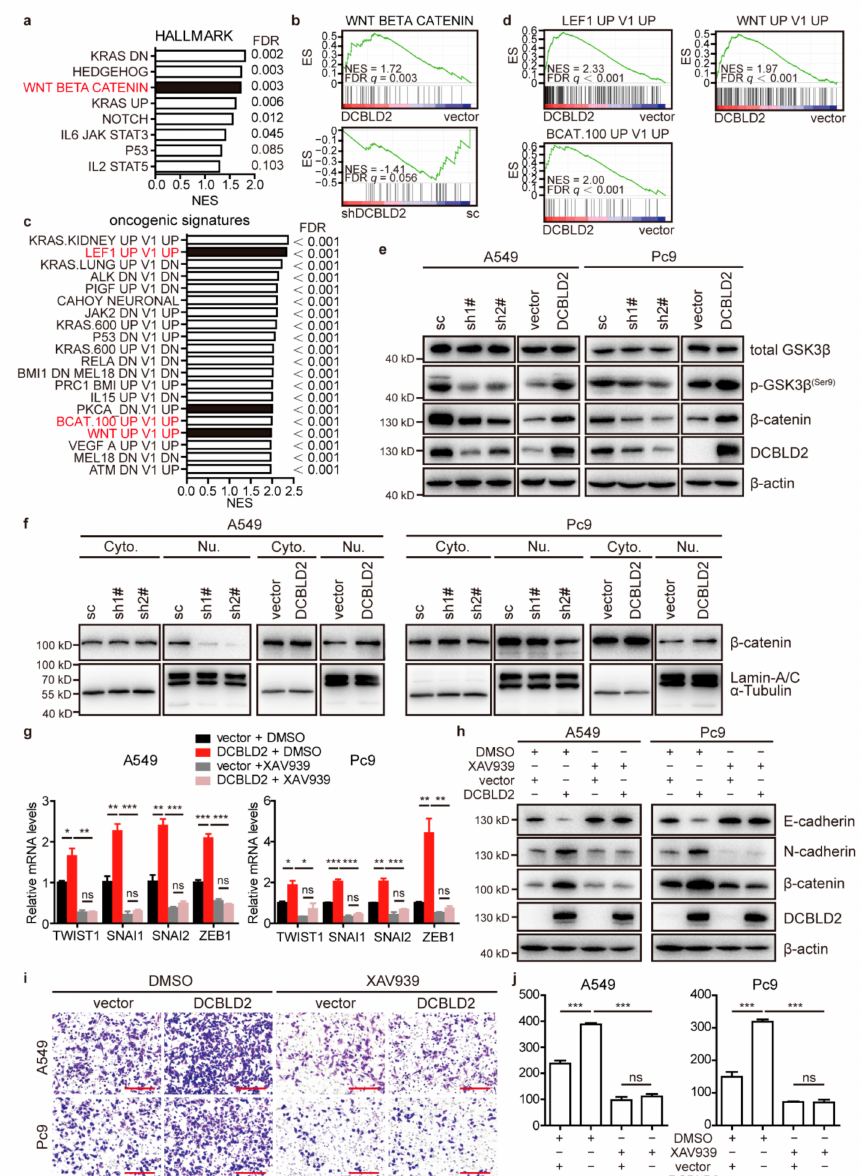
Figure 5. The Wnt/ β -catenin signaling pathway mediates DCBLD2-induced metastasis in LUAD. ( a , b ) Hallmark enrichment classification of signaling pathways of differentially expressed genes in empty vector and DCBLD2-overxpressing A549 cells by GSEA. ( c , d ) Oncogenic signature enrichment classification of differential genes by GSEA. ( e ) The expression of various Wnt/ β -catenin signaling pathway proteins was evaluated by western blot assay in A549 and Pc9 cells. ( f ) Western blot assay of β -catenin expression in A549 and Pc9 cells after nuclear-cytoplasmic fractionation. α -Tubulin and Lamin A/C were used as cytoplasmic and nuclear loading controls, respectively. ( g ) RT-PCR assays of the expression of EMT TFs in empty vector and DCBLD2-transfected cells after treatment with 20 µ M XAV939 or DMSO for 48 h. ( h ) Western blot assay of the expression of E-cadherin and N-cadherin in empty vector and DCBLD2-transfected cells treated with 20 µ M XAV939 or DMSO for 48 h. ( i , j ) Transwell assay showing the effect of β -catenin on DCBLD2-induced cell migration. Empty vector and DCBLD2-transfected cells were pretreated with 20 µ M XAV939 or DMSO for 48 h and then subjected to Transwell assays. Images of the cells on the underside of the membrane of wells are shown in (i) after culture for 8 h in the presence of a chemoattractant. Scale bar: 200 µ m. Quantification of migrated cells is depicted in (j). * p < 0.05, ** p < 0.01, *** p < 0.001, t